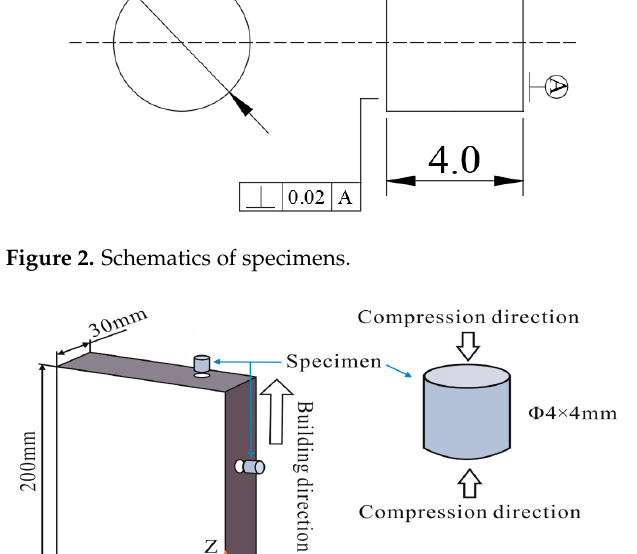
Figure 3. Schematic diagram of the sampling method for specimens.